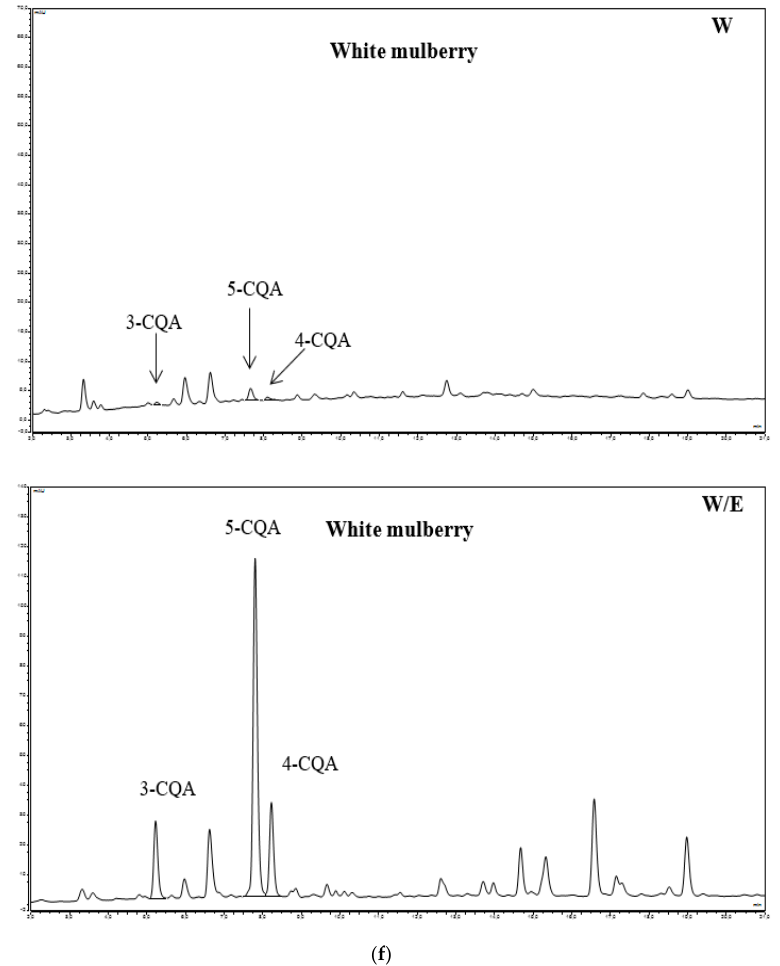
Figure 2. ( a ) HPLC-PDA chromatograms (320 nm) of phenolic acids of caraway water extracts (W) and